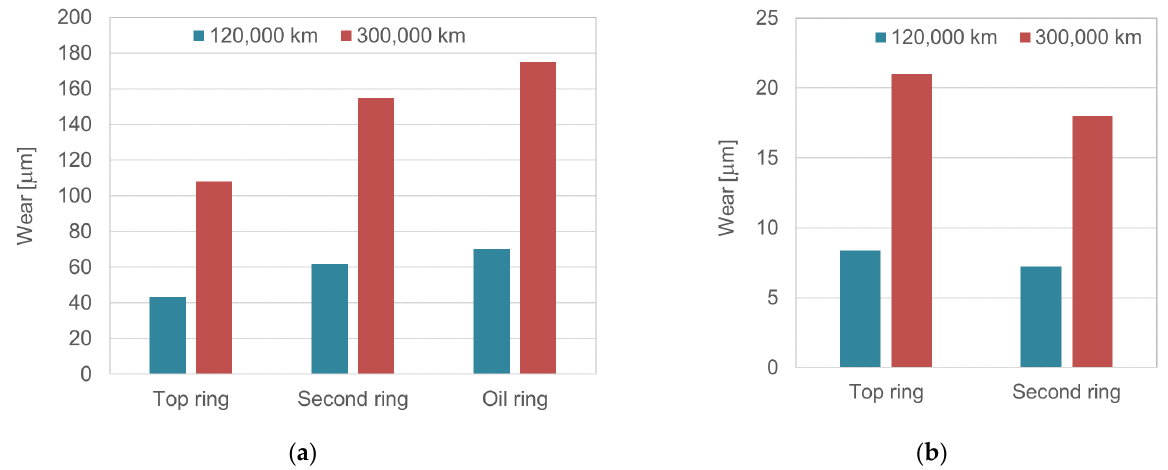
Figure 5. Wear of the rings: ( a ) increase in the ring end gaps; ( b ) changes in the ring